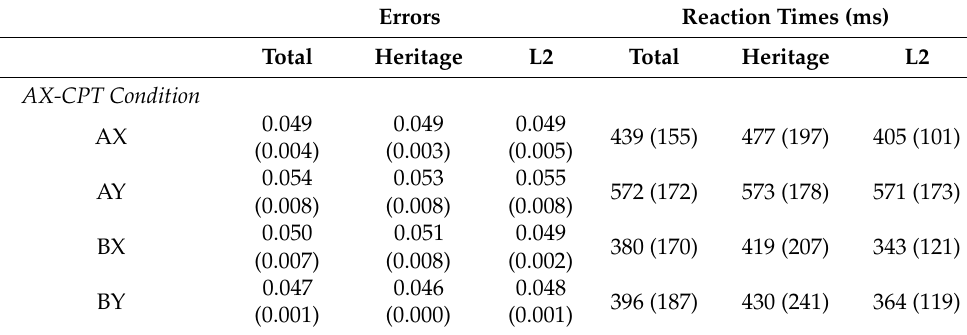
Table 4. Mean proportions of errors and reaction time performances on the AX-CPT for heritage bilingual and L2 speakers of